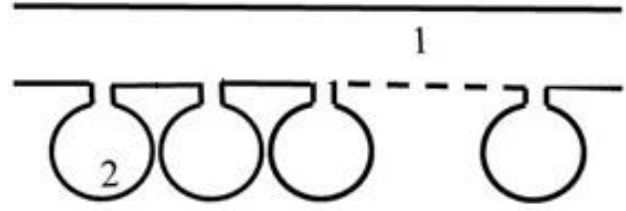
Figure 1. Waveguide 1 with attached Helmholtz resonators 2.